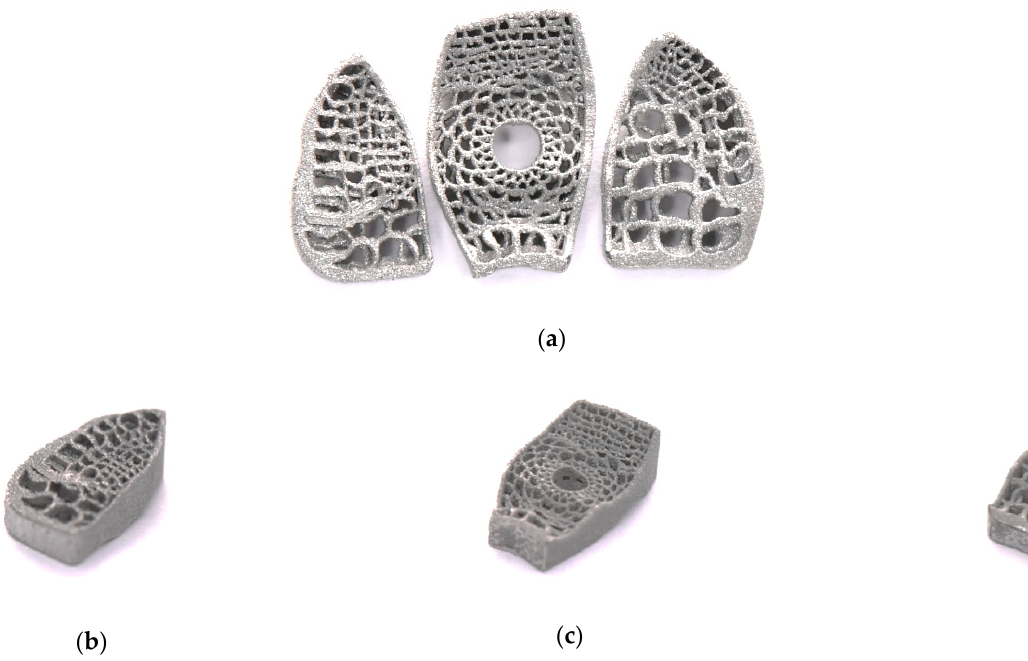
Figure 8. Fusion cages fabricated with SLM. ( a ) Three parts of design, ( b ) Left, ( c ) middle, ( d ) right.